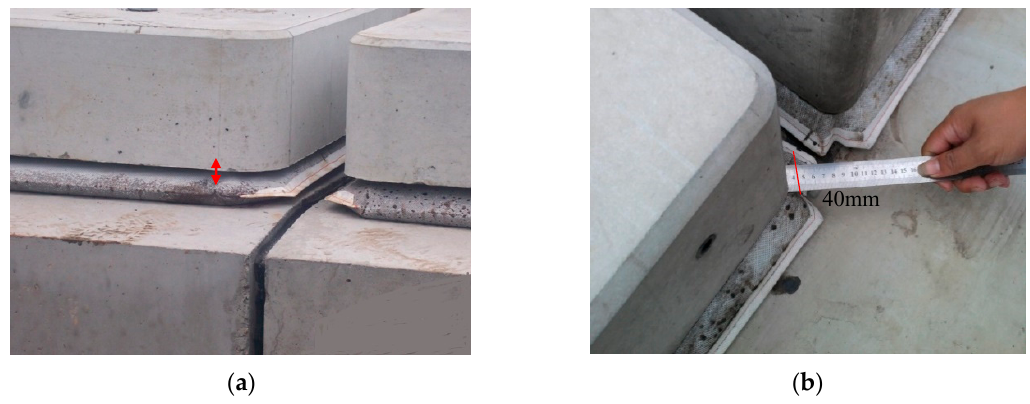
Figure 2. The gap between filling layer and track slab ( a ) vertical direction, ( b ) horizontal direction.